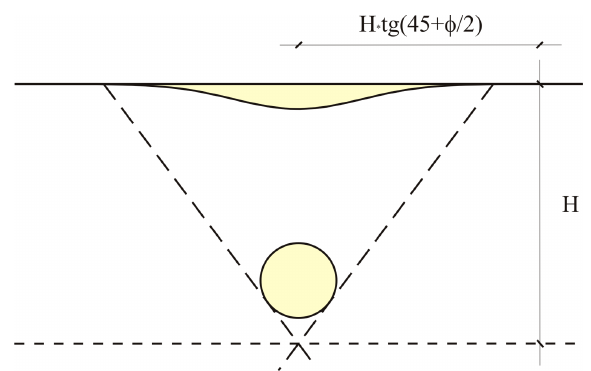
Figure 5. Effect of the level surface deformations on the levelling measurements due to the tunnelling. The horizontal axis counts the number of benchmarks, grouped according to the 80 levelling lines, separated by grey vertical dashed lines.